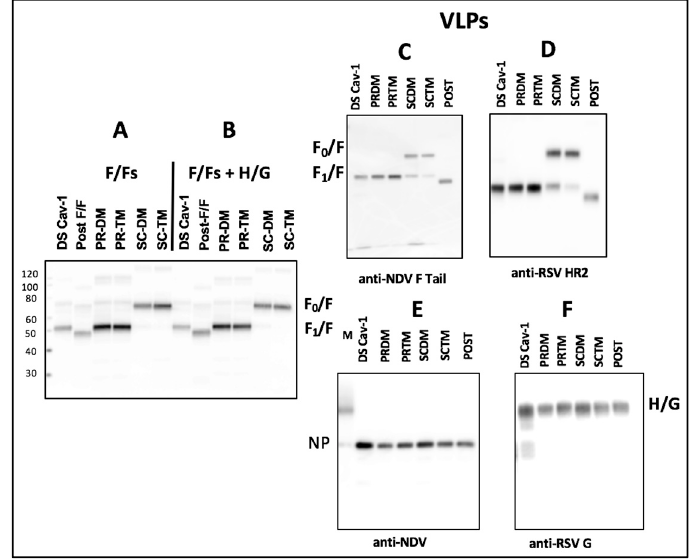
Figure 2. Expression of chimera proteins and VLP content: Panel A : Shown is a western blot of cell surface biotinylated RSV F proteins detected on the surfaces of ELL-0 cells (1 × 10 5 cells) transfected with each of the cDNAs encoding the chimera proteins described in Figure 1. F proteins were detected using the anti-RSV HR2 antibody. Panel B : Shown is a western blot of biotinylated RSV F proteins detected on surfaces of cells transfected as in panel A with the addition of a cDNA encoding the H/G chimera. Panel C – F : Western blots of proteins in purified VLPs adjusted for similar F protein content based on results shown in Figure S1, Supplementary Materials. Panel C , F/F proteins detected with anti-NDV F tail antibody; panel D, F/F proteins detected with anti-RSV HR2 antibody; panel E , NDV NP protein content; panel F , H/G protein content. Anti-RSV does not detect F protein. F0, uncleaved F/F chimera; F1, cleaved F/F chimera; H/G, NDV HN/RSVG protein chimera; NP, NDV NP protein; M, marker proteins.